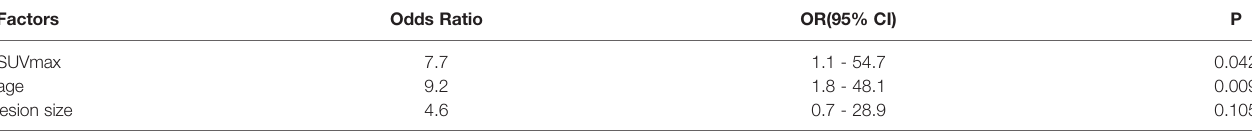
TABLE 3 | Multivariate analysis of malignant tumors in patients with ureteral occupying.